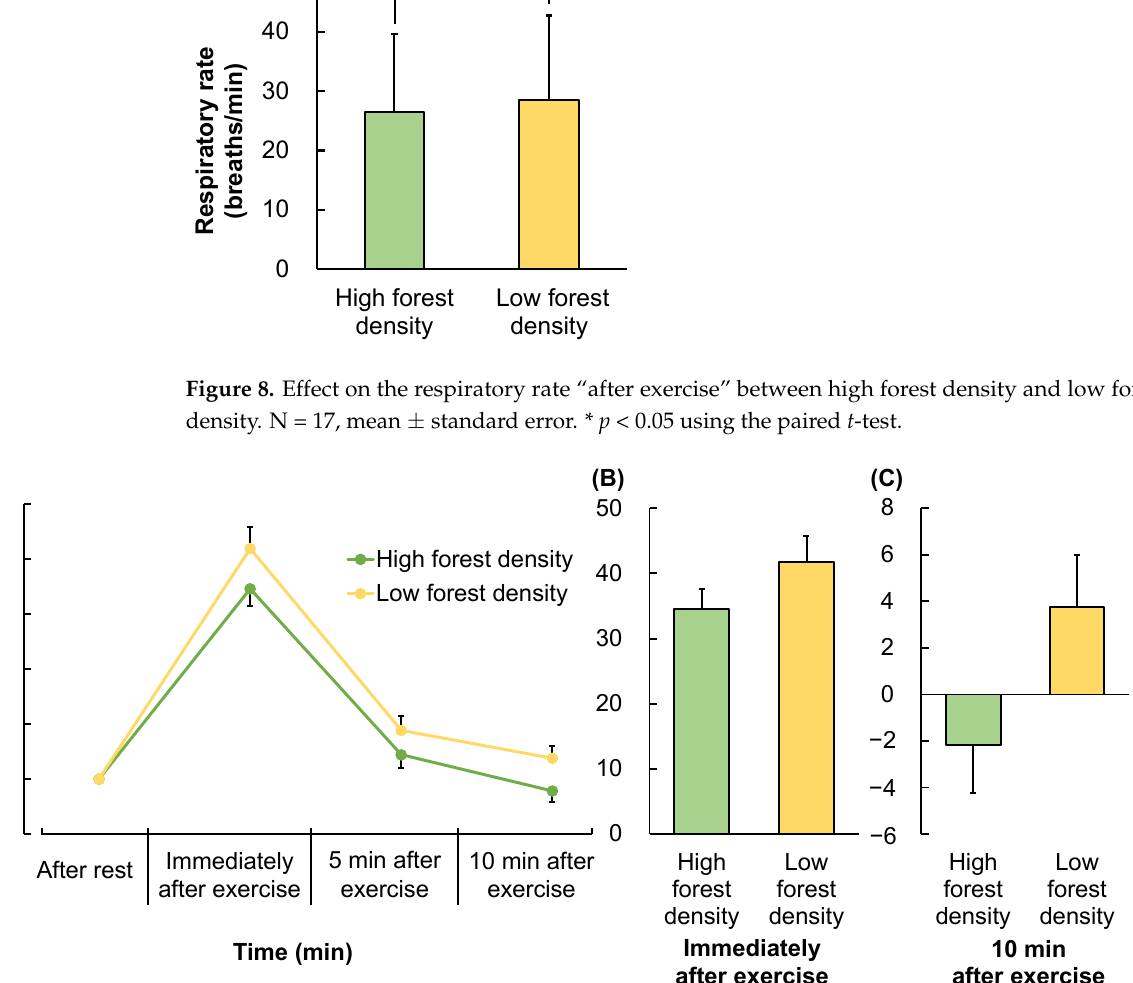
Figure 8. Effect on the respiratory rate “after exercise” between high forest density and low forest density. N = 17, mean ± standard error. * p < 0.05 using the paired t ‐ test.